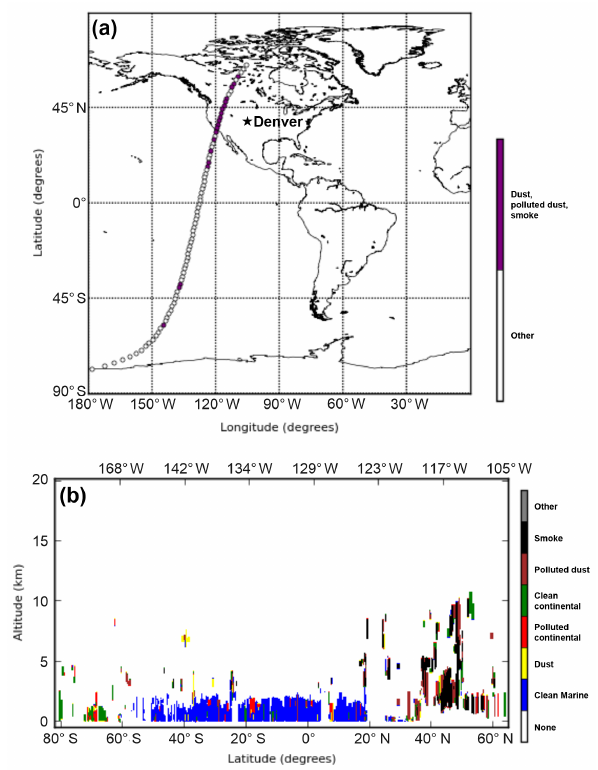
Figure 10. CALIPSO swath data from the night prior to event 1. Swath data contained in the CAL_LID_L2_VFM_ValState1-V3-30 file are from 16 August 2015 at 09:57:00UTC. (a) Map showing CALIPSO coverage, with the purple markers representing locations in the column measurement where dust, smoke, or polluted dust were observed. (b) Vertical profile (in kma.m.s.l.) for all aerosol subtypes of the swath corresponding to (a) .